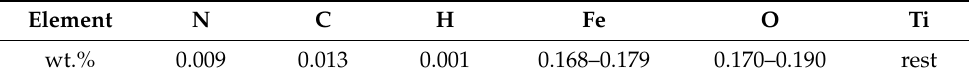
Table 1. The chemical composition of the Ti grade 2 substrate,